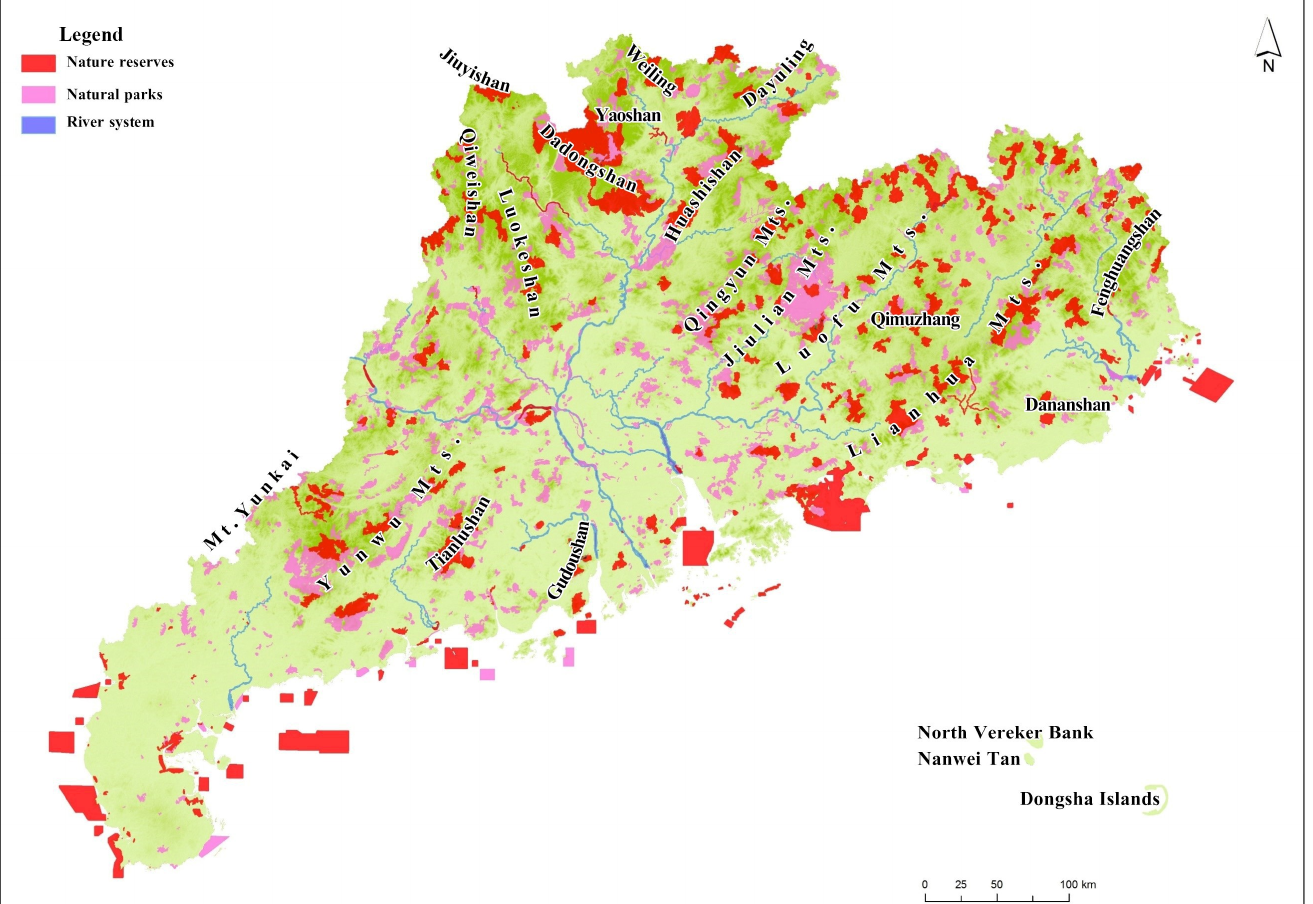
Figure 2. Spatial location relationship between NPAs and mountain